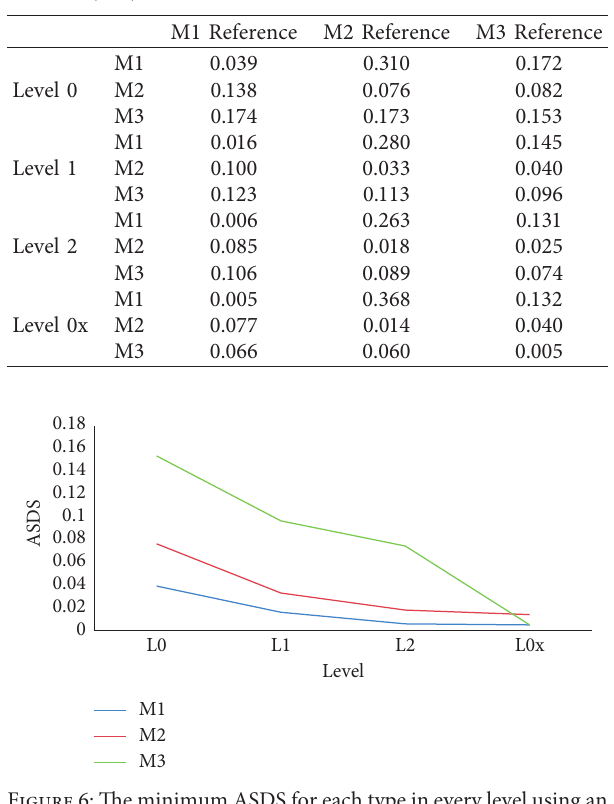
Table 5: Results of ASDS using an internal reference which is the average spectrum of each rock type either in laboratory (L3) or in the field (L3x).